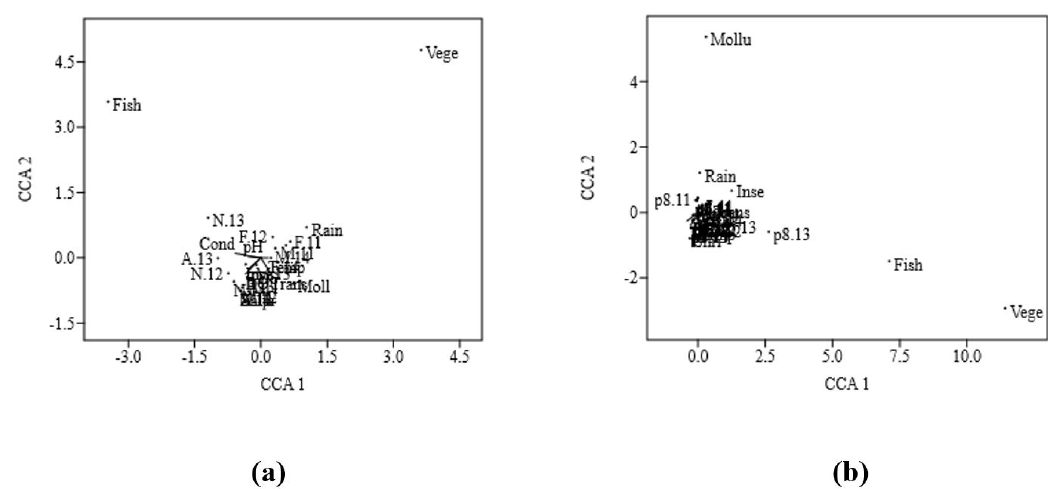
Figure 5. Canonical Correspondence Analysis (CCA) between the Plagioscion squamosissimus Feeding Index (IAi) data for the months (a) of February (F), May (M), August (A), November (N) from 2011 to 2014, and sample points (b) from 1 to 8 from 2011 to 2014 at the Santa Cruz Reservoir, Rio Grande do Norte, Brazil. Table 3. Statistical Analysis of Canonic Correspondence Analysis (CCA) between the Plagioscion squamosissimus Feeding Index (IAi) data and the environmental variables for the months and sample points, sampled quarterly, between February 2011 and November 2014, at the Santa Cruz Reservoir, Rio Grande do Norte, Brazil. Figure 4. a